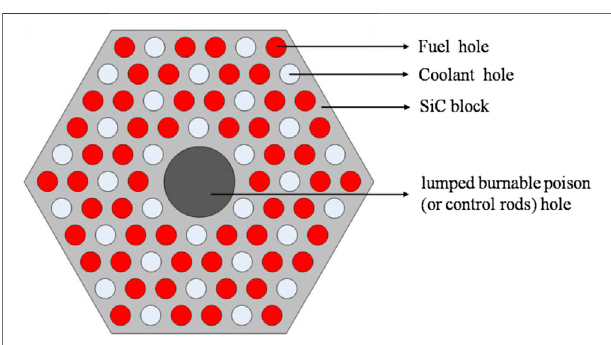
FIGURE 2 | S-CO 2 – cooled reactor standard fuel assembly.